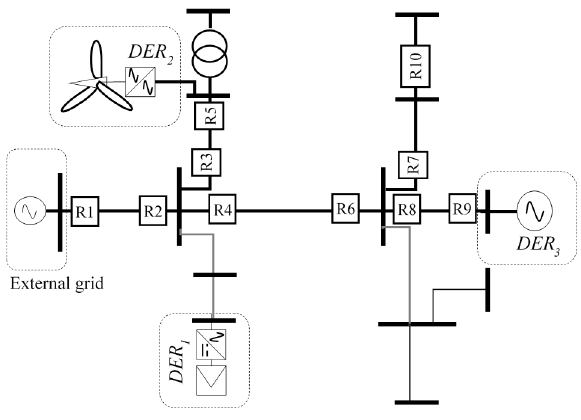
Figure 6. Modified IEEE 13-node test feeder as a microgrid.